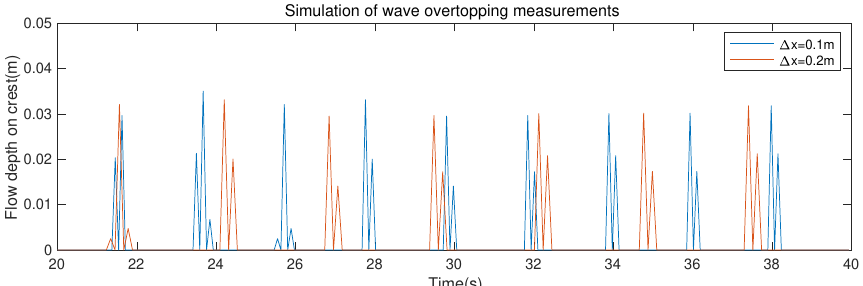
Figure 9. Exceeding water surface elevations over the structure